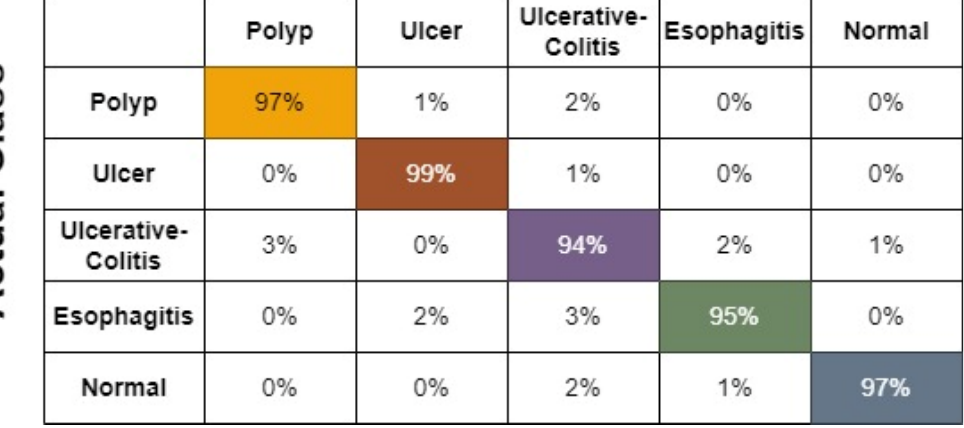
Figure 10. Confusion matrix using softmax classifier for contrast enhanced augmented dataset.